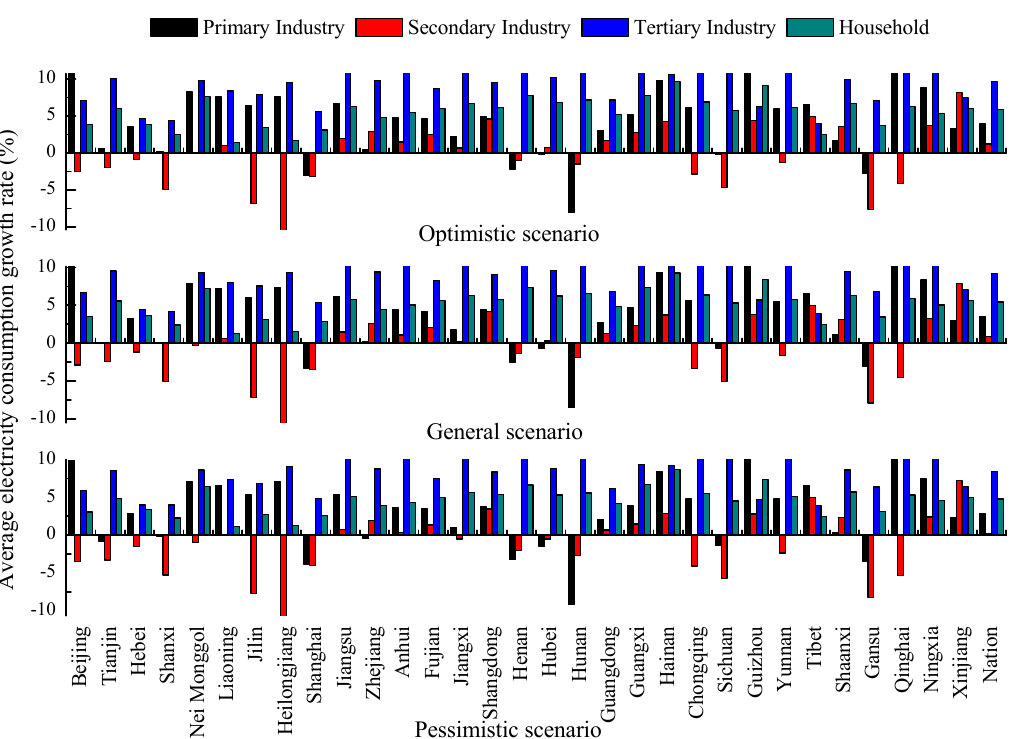
Figure 5. National and regional average electricity consumption growth rate of different sectors by scenario.